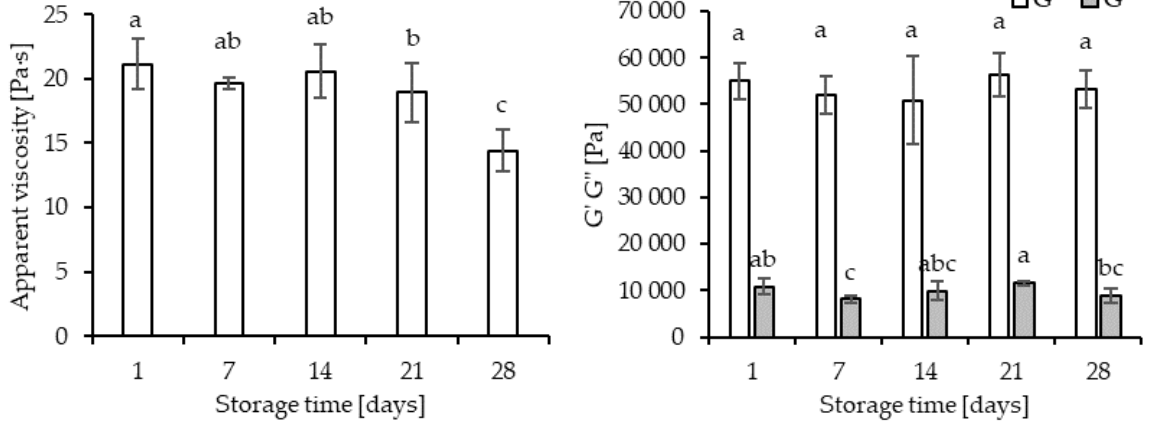
Figure 1. Texture properties of the milk fat-inulin spread. Values are means. Means with different letters for the same texture feature are significantly different ( p ≤ 0.05).